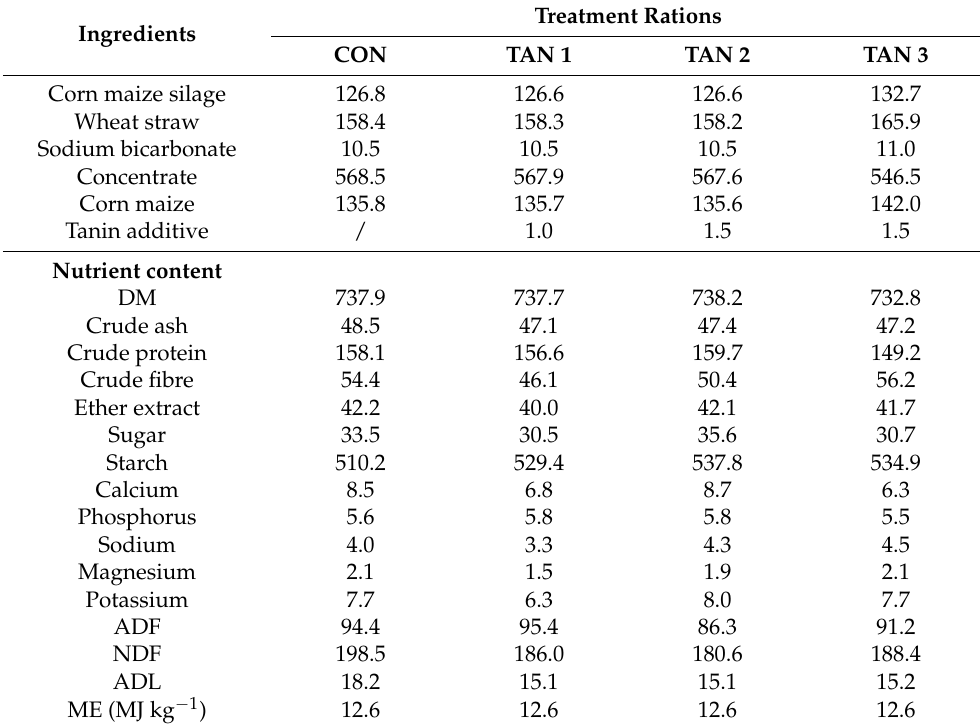
Table 1. Ingredients and chemical composition of total mixed ration (g kg − 1 DM).